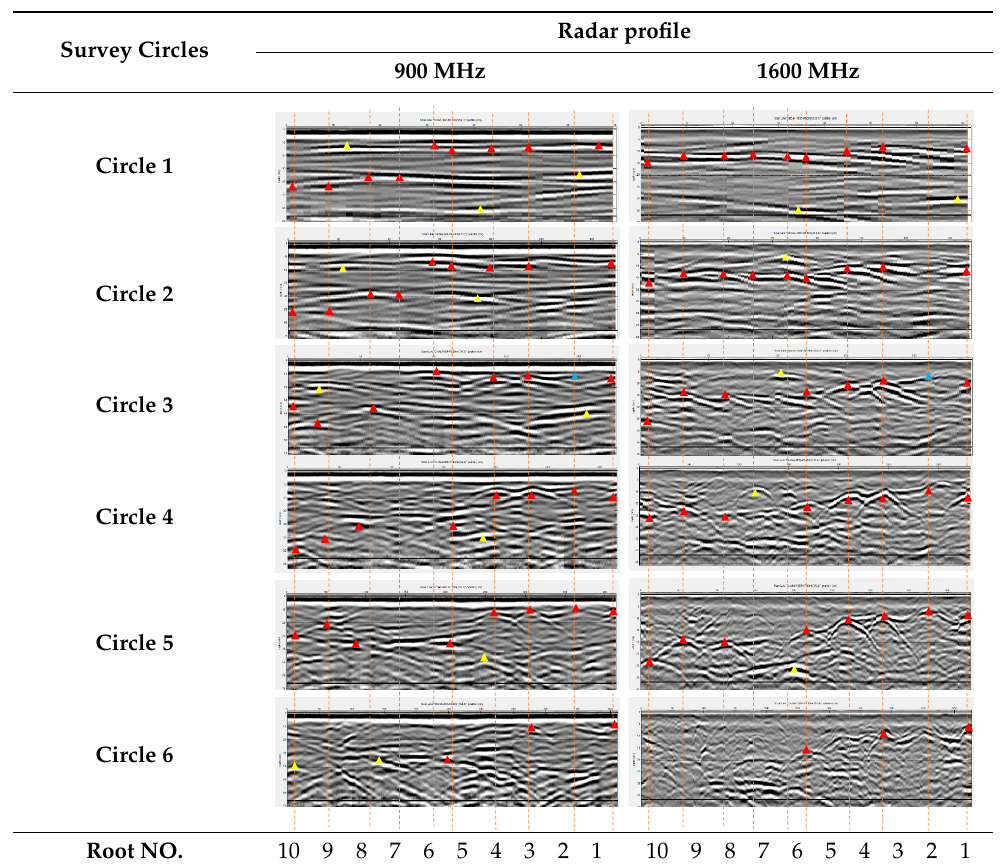
The red arrow represents the detection of an actual root (true positive). The yellow arrow represents the detection of a false root (false positive). The blue arrow represents the missed (undetcted) root (false negative). Table 8. Detection accuracy, precision, and recall of the simulated